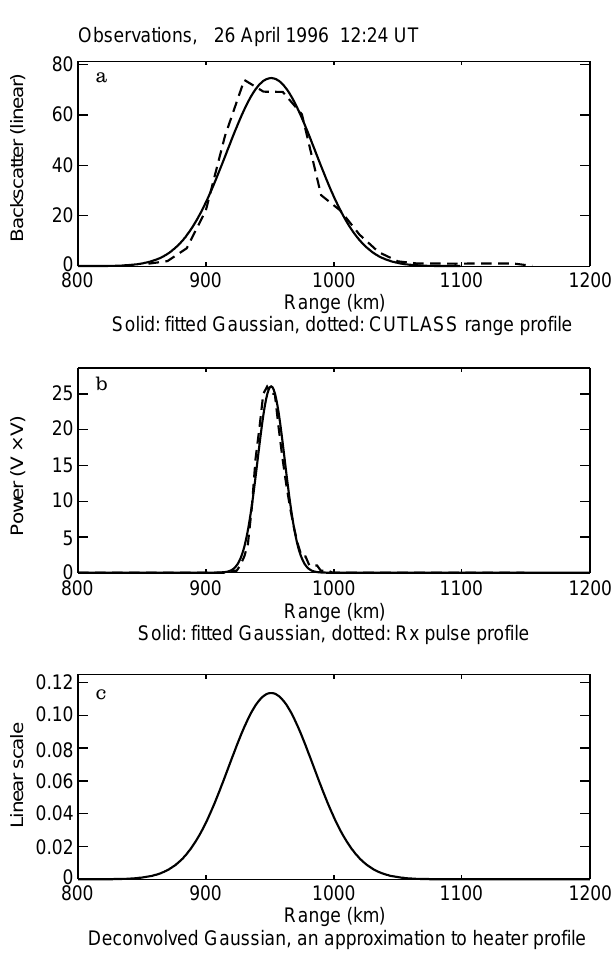
Fig. 3a–c. Observations for 1224UT on 26 April 1996. a The dotted line represents backscatter power from CUTLASS Finland along beam 5. The solid line is a Gaussian function fitted to the data. b The dotted line represents the power produced by a pulse fed into a CUTLASS receiver. The solid line is a Gaussian fitted to the profile. c An analytical profile produced by deconvolving the Gaussian fitted to the pulse profile from the curve fitted to the